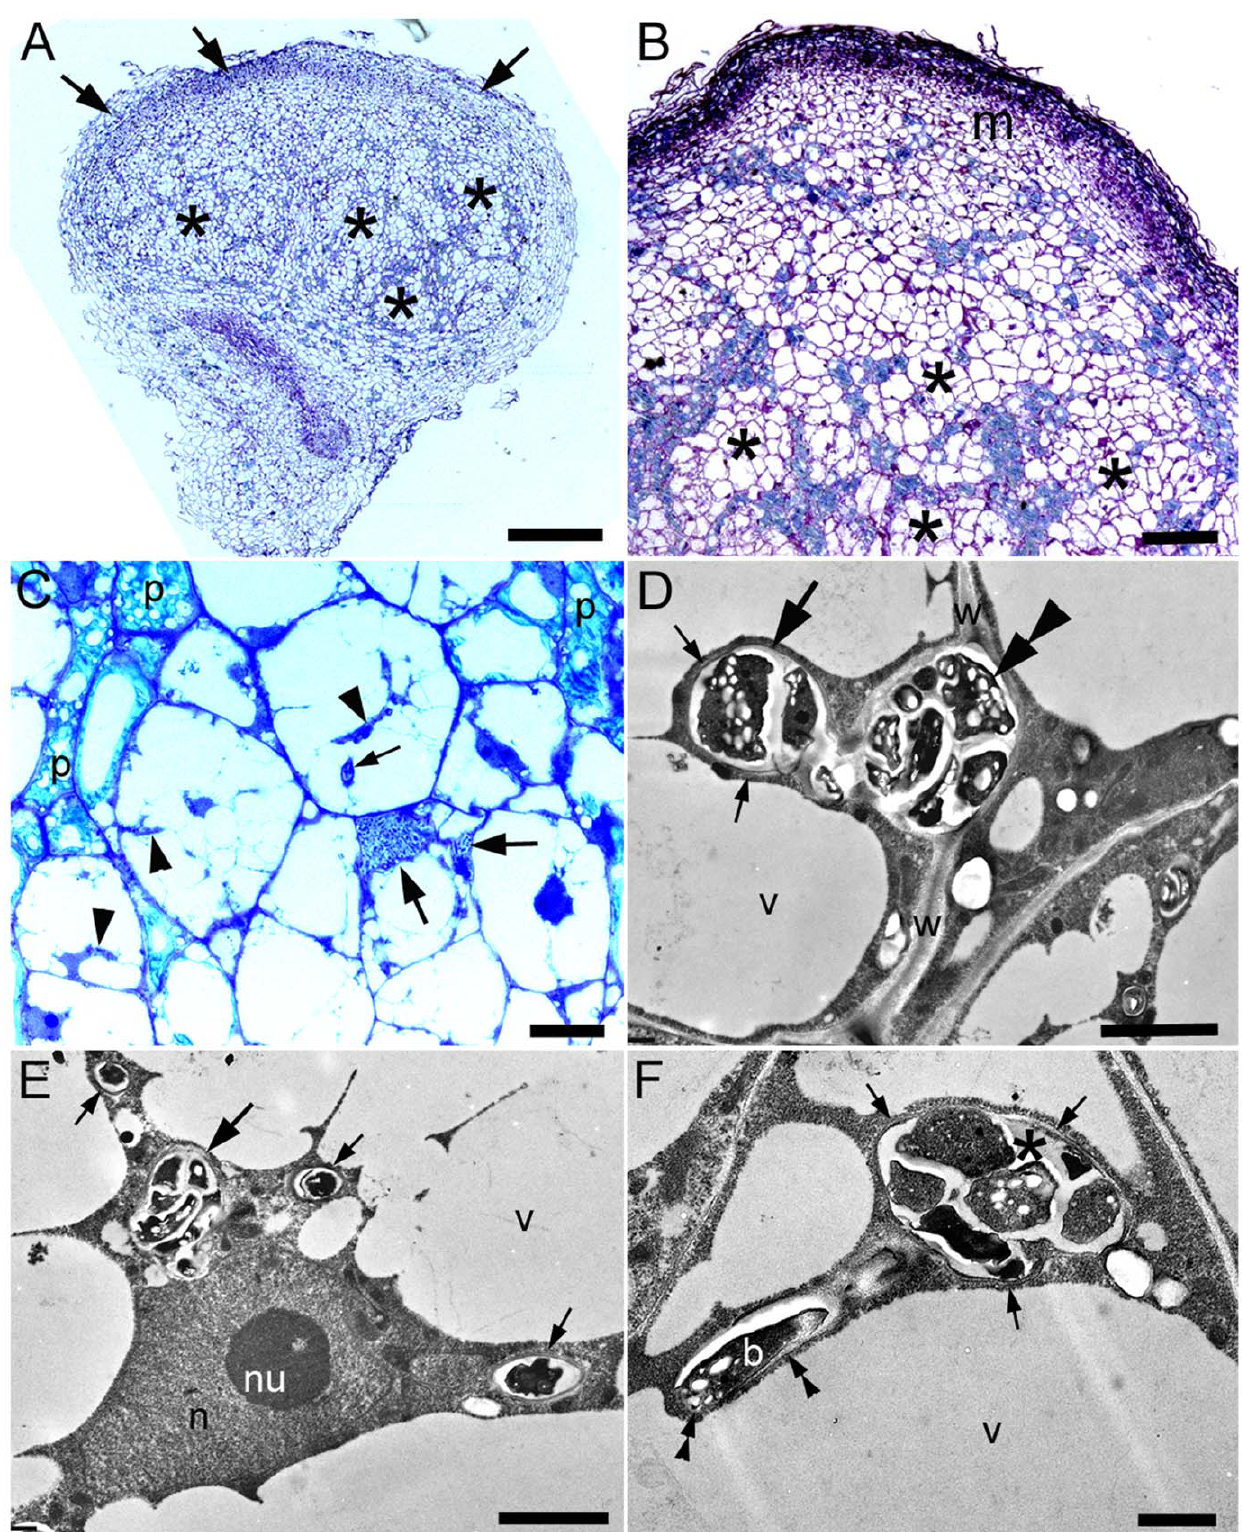
Figure 3. Light microscopy (A–C) and TEM (D, E, F) of developing (i.e. pre-N-fixing) nodules on a D.wilsonii root at 63 dai with Bradyrhizobium strain DW12.5. (A) The young nodules are spherical/oval in shape, but a broad apical meristem is still apparent (arrows), as would be expected in an indeterminate nodule. The remainder of the nodule is effectively an ‘‘invasion zone’’, as it is being actively invaded by rhizobia (see subsequent panels), but there are no N-fixing cells containing bacteroids established at this stage. (B) The invasion zone behind the large meristem (m) is divided into ‘‘sectors’’ (*) by files of blue-green phenolic-containing cells. (C) High magnification view of a ‘‘sector’’ within the invasion zone that